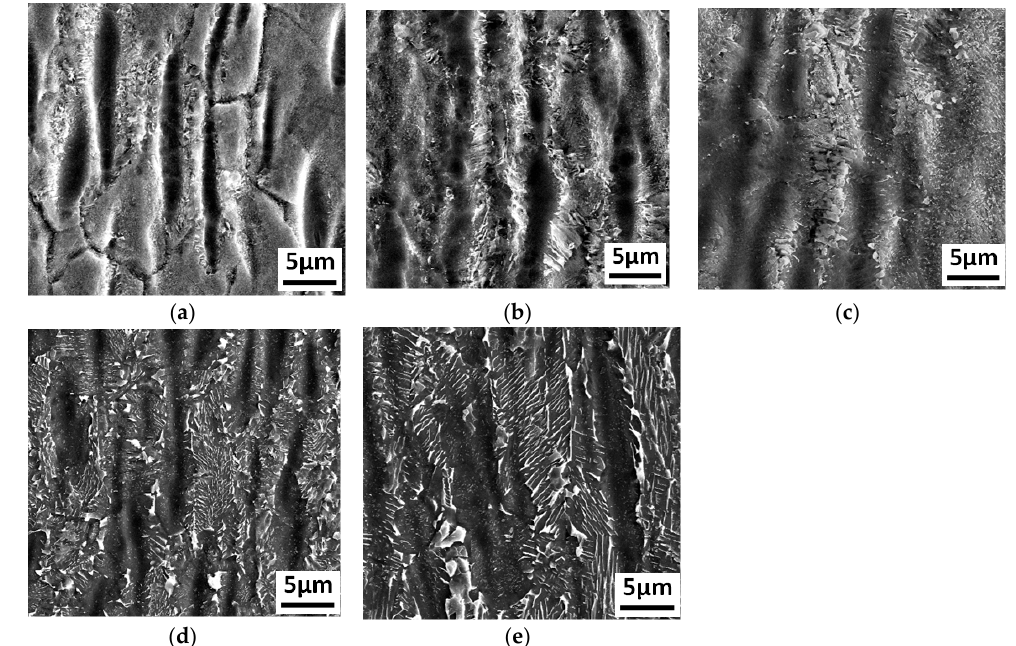
Figure 8. The Ti 3 Al LFW joint microstructures in the TMAZ after heat treatments at different temperatures: ( a ) after heat treatment at 700 °C, ( b ) after heat treatment at 750 °C, ( c ) after heat treatment at 800 °C, ( d ) after heat treatment at 850 °C, and ( e ) after heat treatment at 900 °C. The microstructure variation in the TMAZ close to the side of the base metal was different than that in the other two zones. The morphology of the α 2 phase did not change significantly with